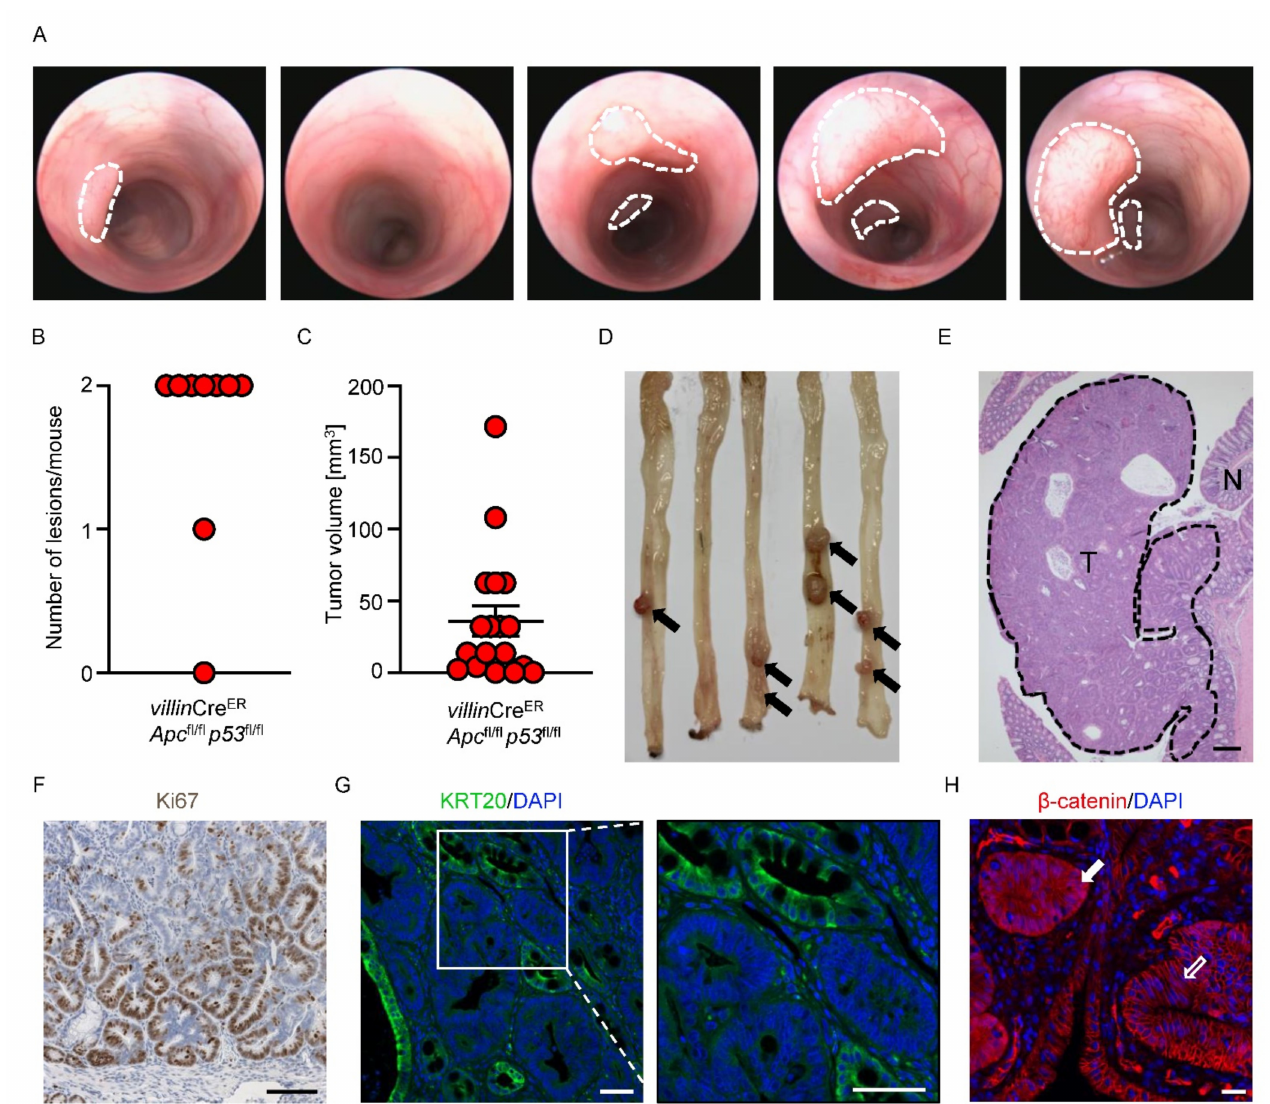
Figure 2. Colonoscopy-guided generation of locally defined tumors in a genetic model. ( A ) Repre- sentative colonoscopy images. Dashed lines mark the tumors. ( B , C ) Quantification of ( B ) number of tumors and ( C ) tumor volume detected 6 weeks after injection. ( n = 9 mice). ( D ) Representa- tive images of the colon in the same order as the colonoscopy images in ( A ). Arrows indicate the macroscopically visible tumors. ( E ) Representative H&E images of a colonic tumor. Dashed line marks tumor area (T) and N the normal mucosa. Scale bar indicates 200 µ m. ( F ) Representative immunohistochemistry image of Ki67 on a villin Cre ER Apc fl/fl p53 fl/fl tumor. Scale bar indicates 100 µ m. ( G ) Representative immunofluorescence images of KRT20 (green) on a villin Cre ER Apc fl/fl p53 fl/fl tumor. Scale bars indicate 50 µ m. ( H ) Representative immunofluorescence image of β -catenin (red) on a villin Cre ER Apc fl/fl p53 fl/fl tumor. The empty arrow marks membranous and the filled arrow marks nuclear localized β -catenin. Scale bar indicates 20 µ